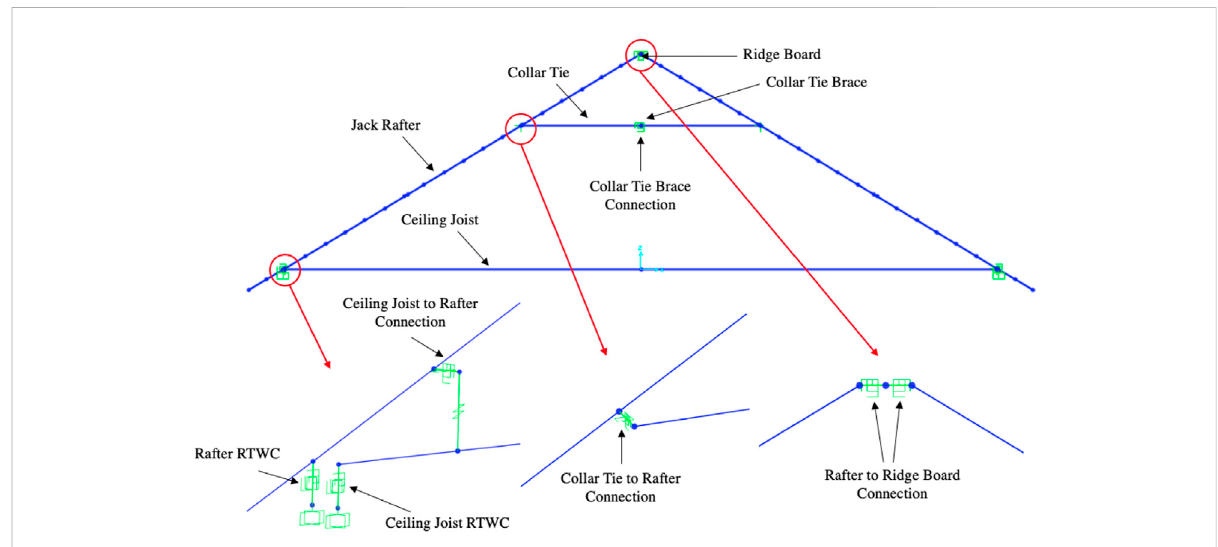
FIGURE 7 De fi nition of all members and connections in the initial model.